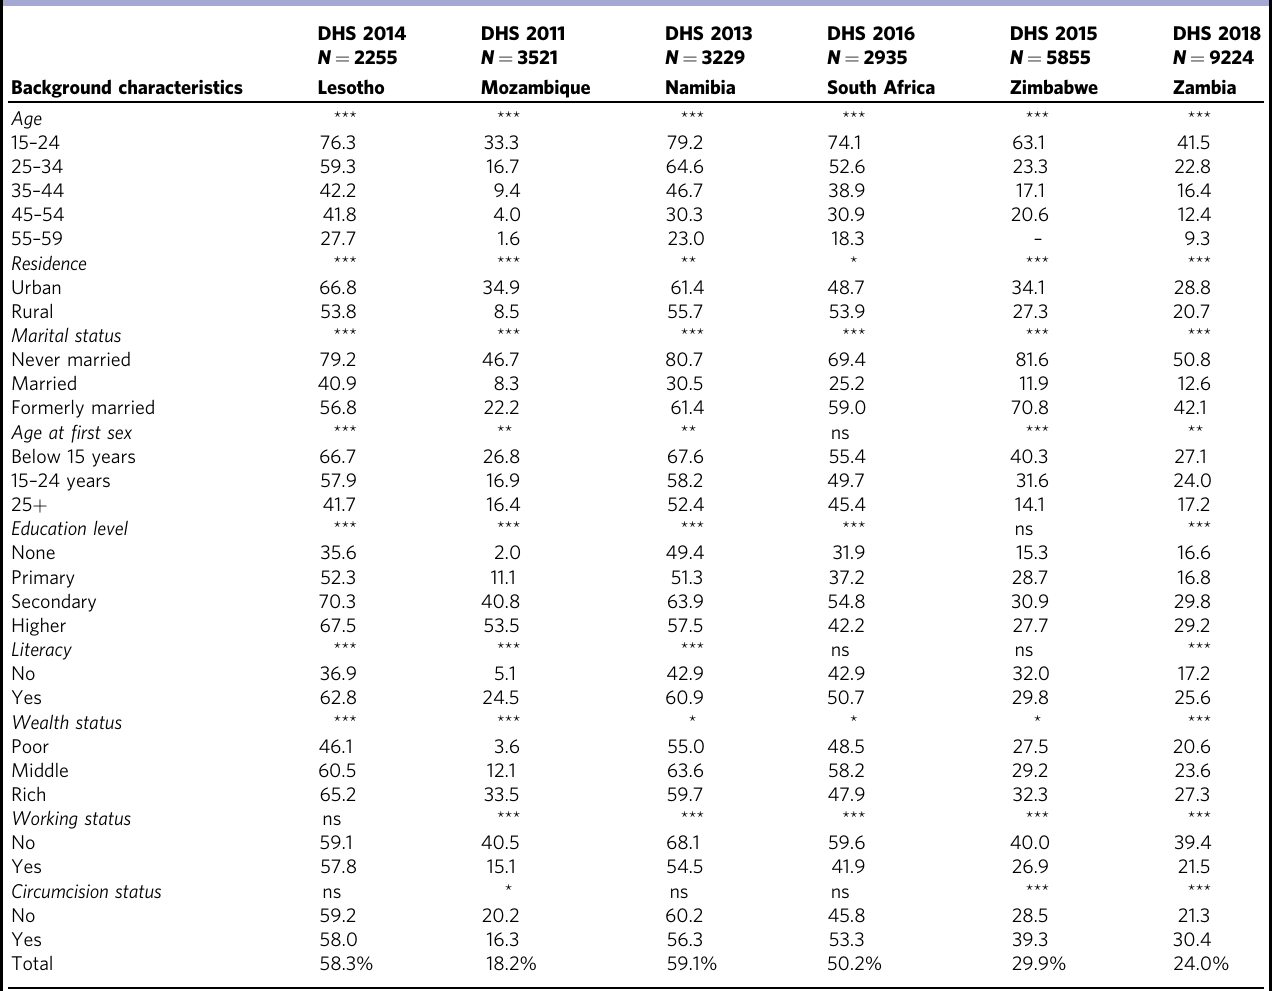
Table 1 Percentage distribution of men who used condom with most recent partner by background characteristics, Southern